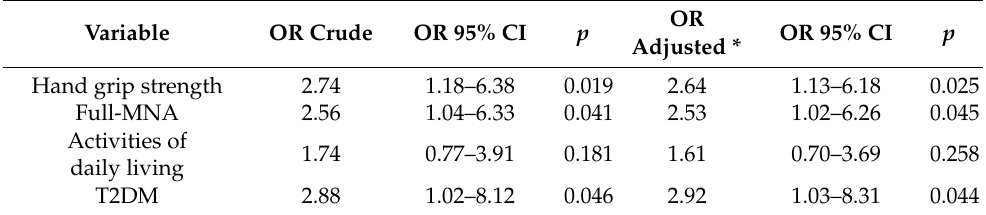
Table 5. Crude and adjusted logistic regression OR of handgrip strength and nutritional status, type 2 diabetes mellitus, and plasma 25(OH)D concentration in community dwelling Mexican older